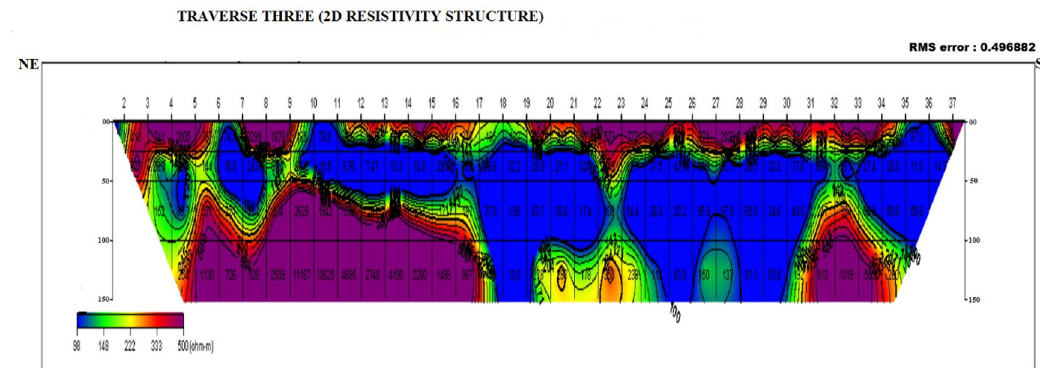
Figure 11. 2D Resistivity Structure of Traverse 3.